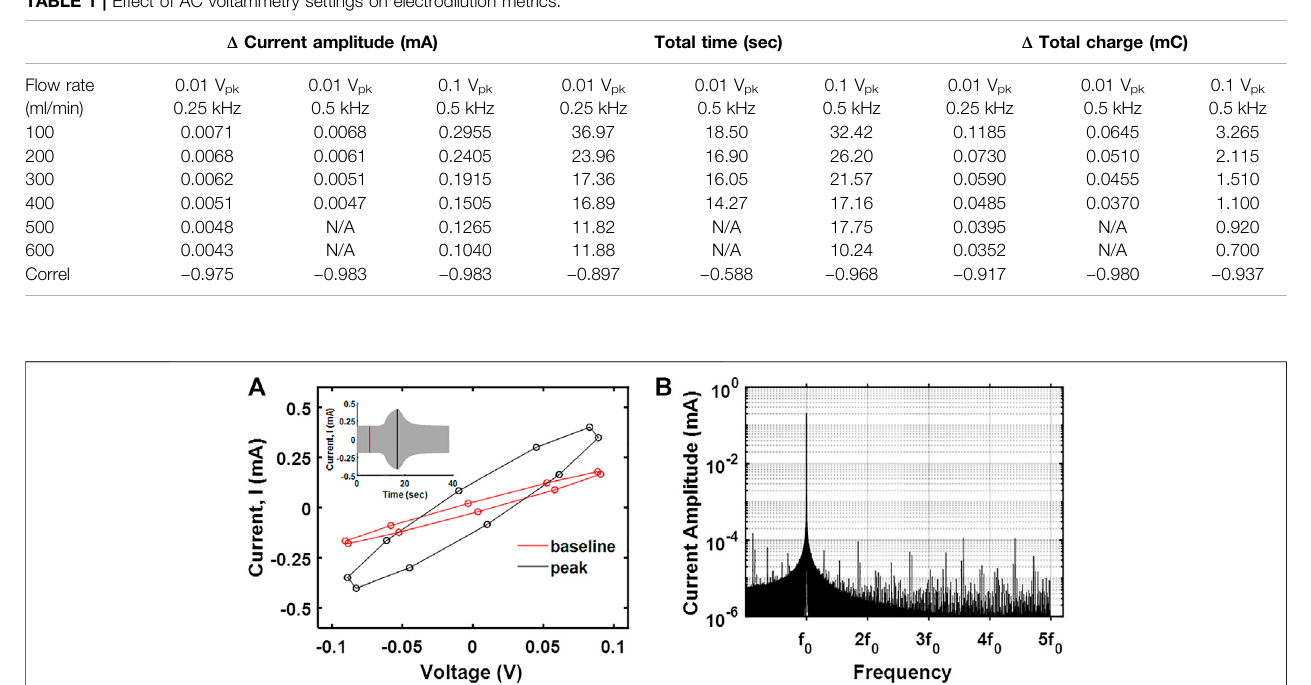
FIGURE 5 | (A) I – V curve at the peak response and baseline for saline electrodilution in water. (B) The frequency spectrum of the transient current measured showing the fi rst fi ve harmonics.